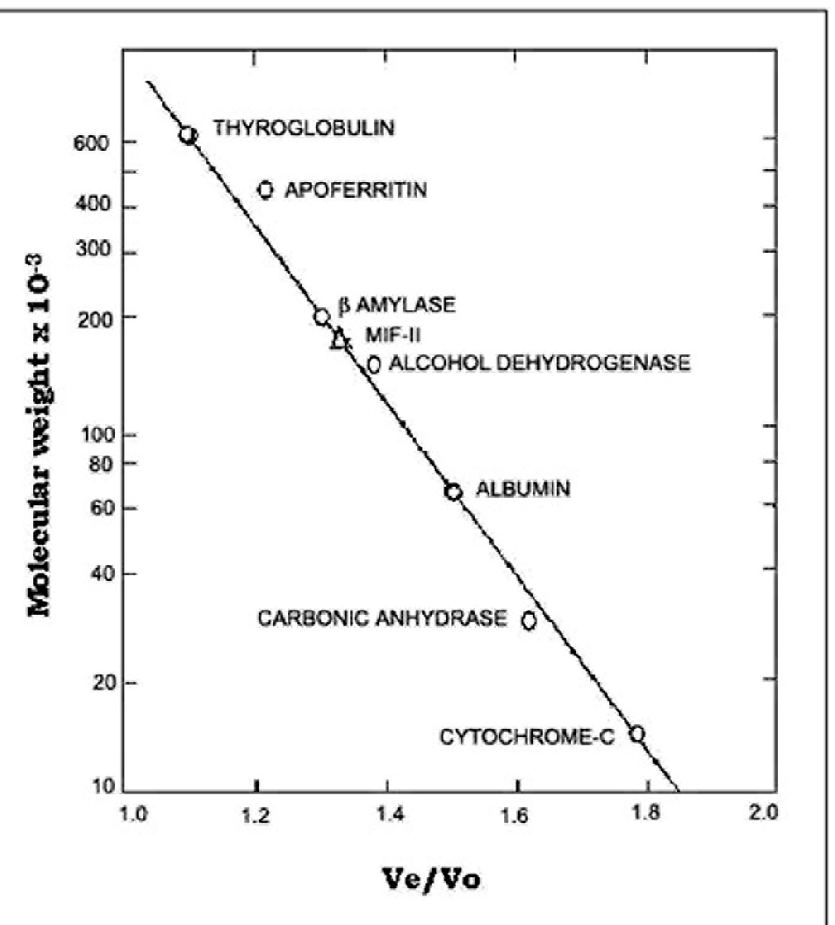
Figure 2. Determination of molecular weight of MIF-II by Sephacryl S-300 gel filtration. The molecular weight of MIF-II was estimated using a column of Sephacryl S-300 (1 6 60 cm) by modification of the method of Wollny et al. (1981). The Mol. Wt. Markers used as standard were thyroglobulin (669 kDa), apoferritin (443 kDa), b -amylase (200 kDa), alcohol dehydrogenase (150 kDa), BSA (66 kDa), carbonic anhydrase (29 kDa) and cytochrome C (12.4 kDa).